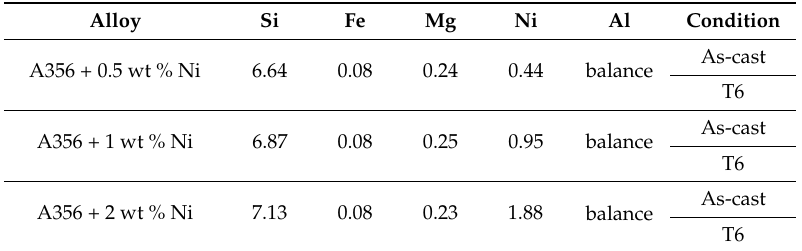
Table 1. The chemical composition of the investigated alloys (wt